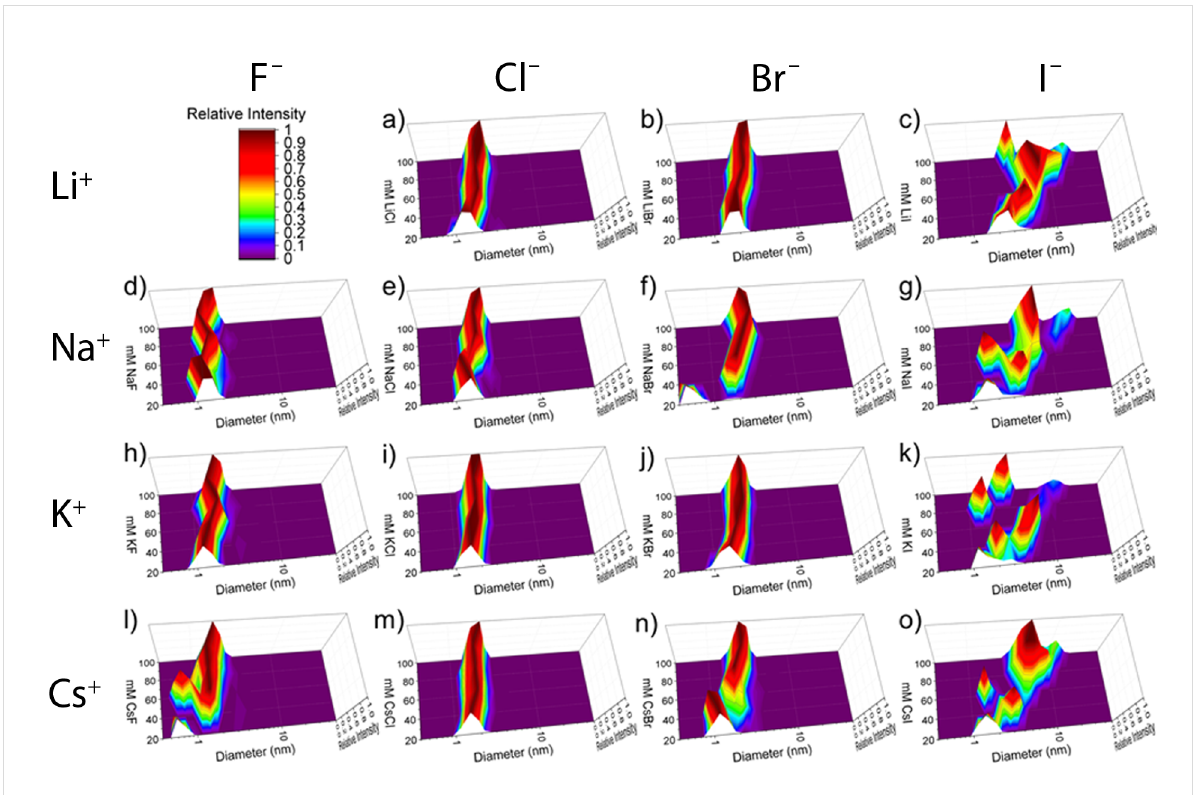
Figure 3: Representative plots of the volume-weighted distribution obtained by DLS for salts titrated into 2.00 mM 2 : a) LiCl, b) LiBr, c) LiI, d) NaF, e) NaCl, f) NaBr, g) NaI, h) KF, i) KCl, j) KBr, k) KI, l) CsF, m) CsCl, n) CsBr, o) CsI. Scale shown in the upper left corner. The x -axis represents hydrodynamic diameter, the y -axis the concentration of the respective salt (mM), and the z -axis the relative intensity.